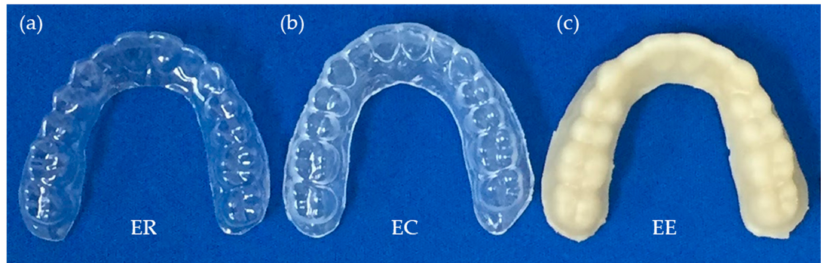
Figure 1. ( a ) Aligner formed using ER; ( b ) aligner formed using EC, and ( c ) aligner formed using